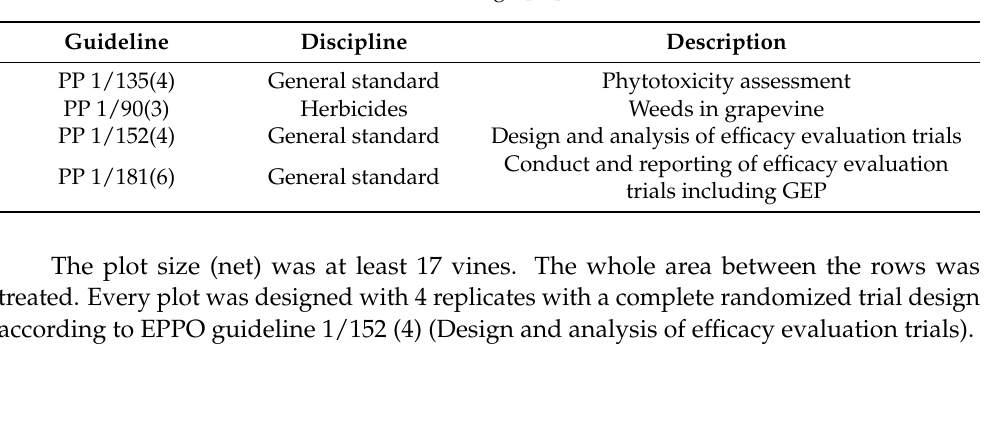
Table 4. EPPO Guidelines used for field trials design